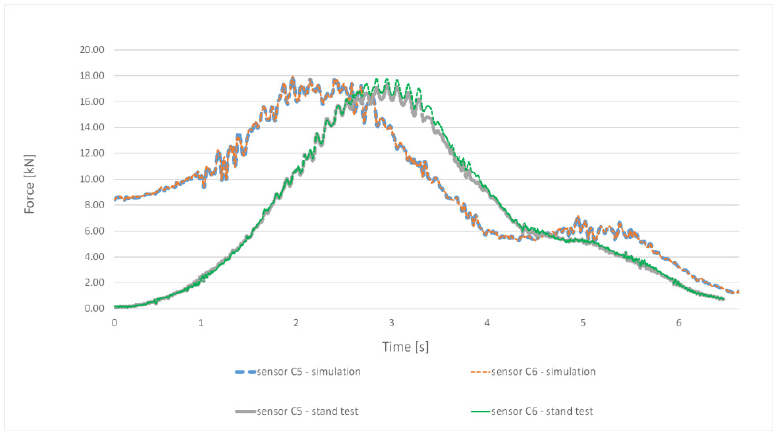
Figure 6. Arrangement of the force transducers on the measuring path: start of the ride (A), end of the ride (B) The time curves of forces in vertical suspensions are presented in Figure 7.